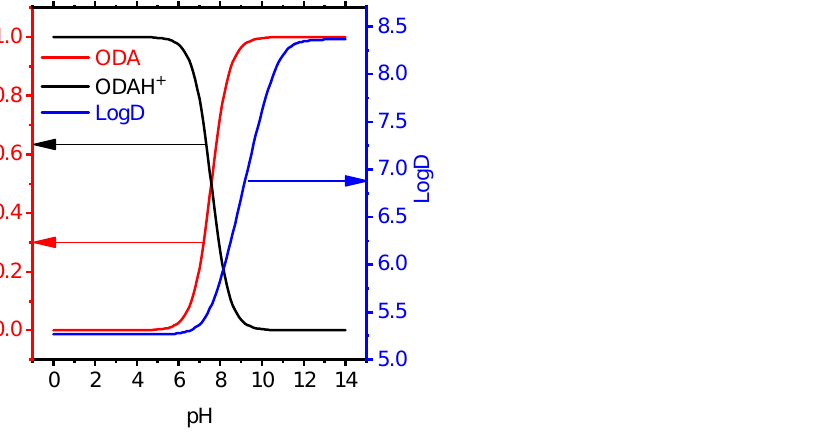
Figure 3. Effect of pH on the molar fraction and distribution coefficient of octadecylamine particles.